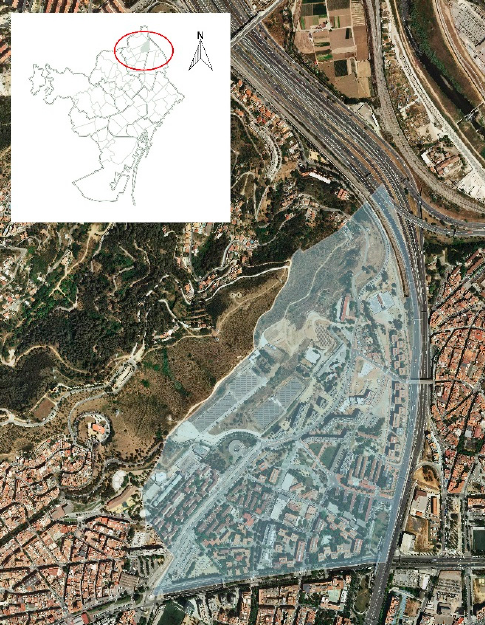
Figure 3. Location of the Trinitat Nova neighborhood. Source: own elaboration.